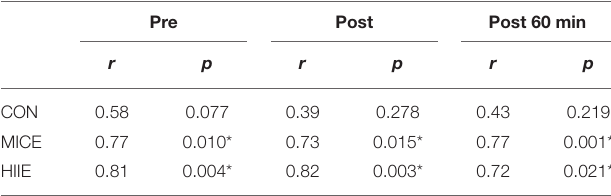
TABLE 3 | Salivary IgA (S-IgA) concentration, salivary IgA (S-IgA) secretion rate in time before, after, and 1h after exercise. Before